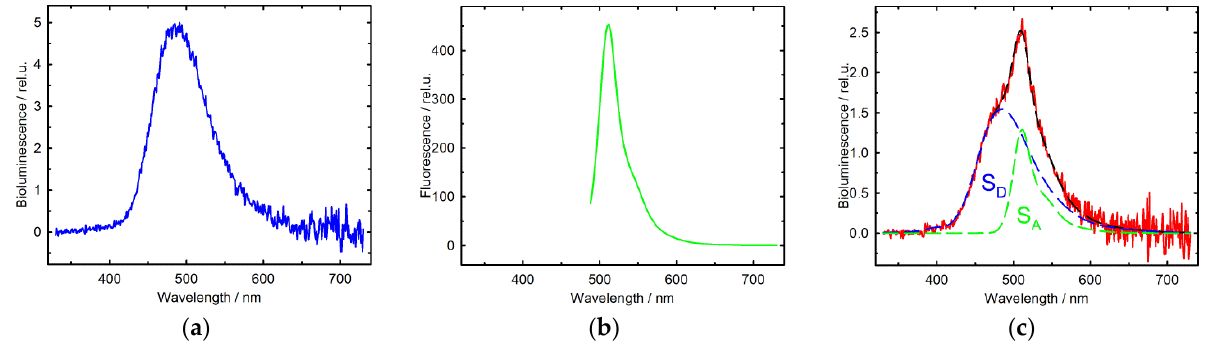
Figure 1. Emission spectra of E. coli cells: Bioluminescence ( a ) and Fluorescence ( λ exs 470 nm) ( b ) spectra of the mixture of cell lysates after expression p11cjoe/RLuc and p11cjoe/barstar-EGFP; ( c ) The bioluminescence spectrum of E. coli cells after co-expression of p28/barnase-RLuc and p11cjoc/barstar-EGFP plasmids.